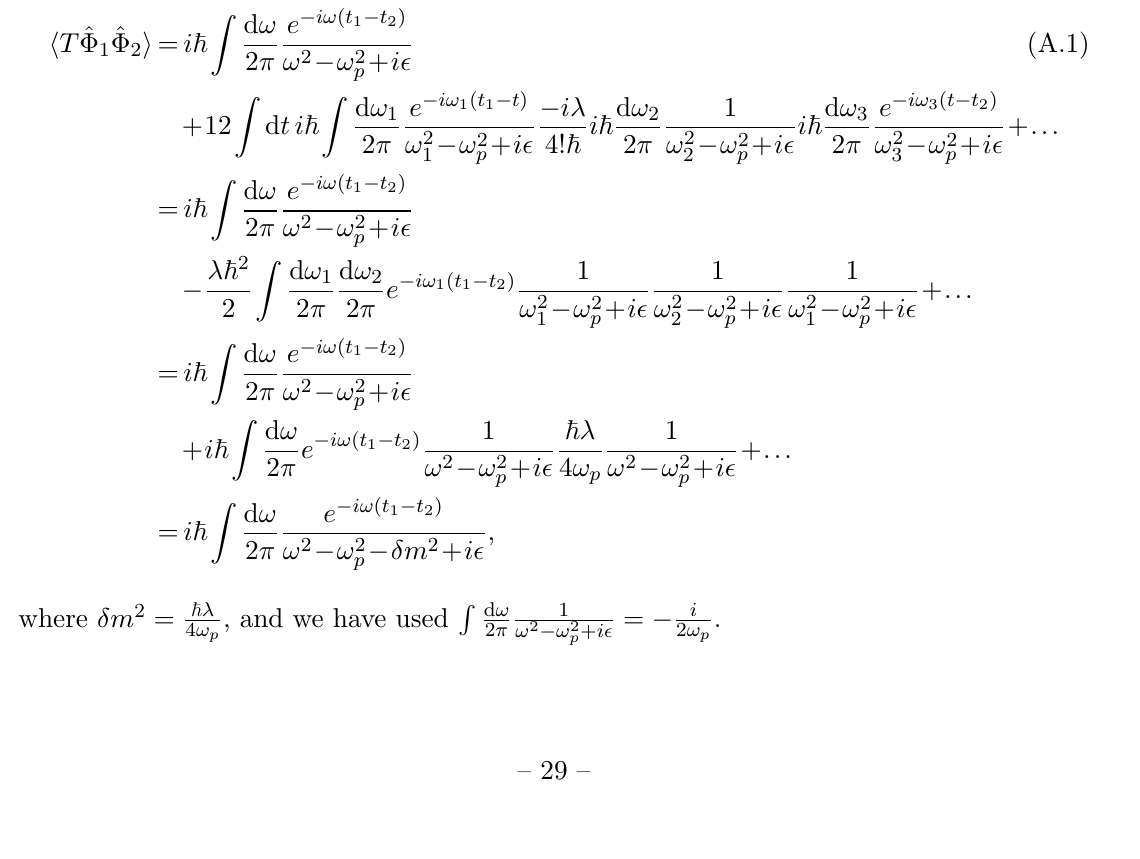
Figure 8 . Loop correction to the time-ordered two-point correlator, with the thick solid line being the Feynman